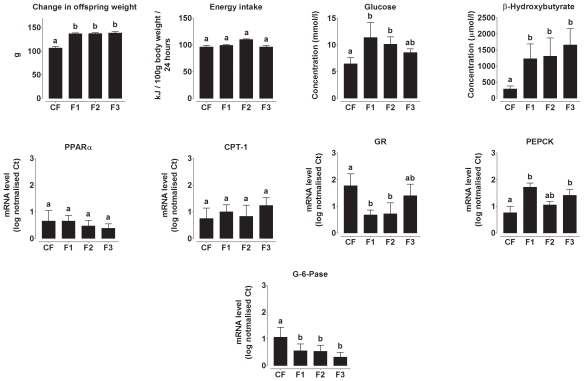
Offspring phenotype and mRNA expression of genes involved in hepatic gluconeogenesis and ketogenesis.Change in offspring body weight on day 70 compared to weaning, offspring energy intake on day 70, fasting glucose and β-hydroxybutyrate concentrations on postnatal day 70. Hepatic PPARα, carnitine palmitoyltransferase-1 (CPT-1), glucocorticoid receptor (GR), phosphoenolpyruvate carboxykinase (PEPCK), (I) glucose-6-phosphatase (G-6-Pase) mRNA expression. Values are mean ± SD for n = 5−7 rats per group. Values with different letters are significantly different (P<0.05).